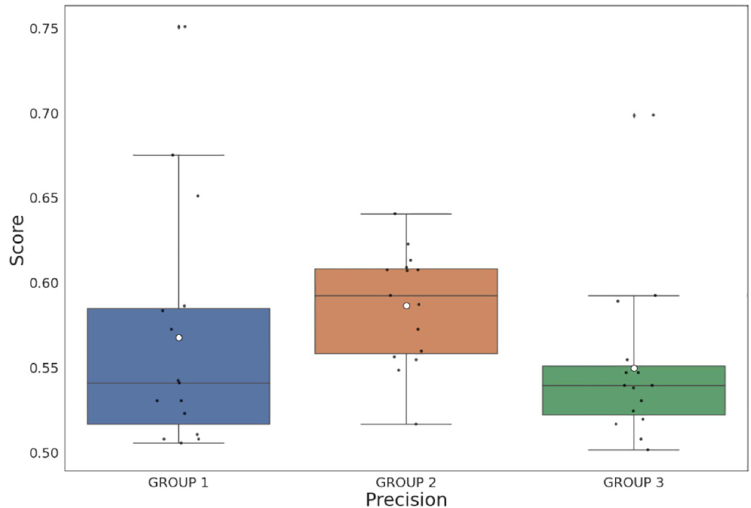
Fig 3. Precision scores among every participant divided into groups, where Group 1: older people, Group 2: people with intellectual disabilities and Group 3: control users.